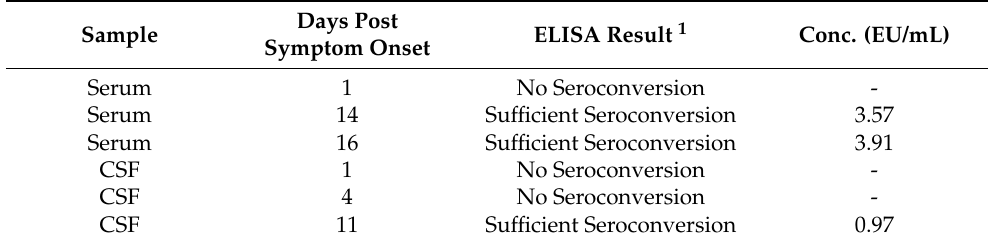
Table 1. Quantitative anti-rabies ELISA for sequential serum and CSF samples collected from a 40-year-old male with clinical suspicion of